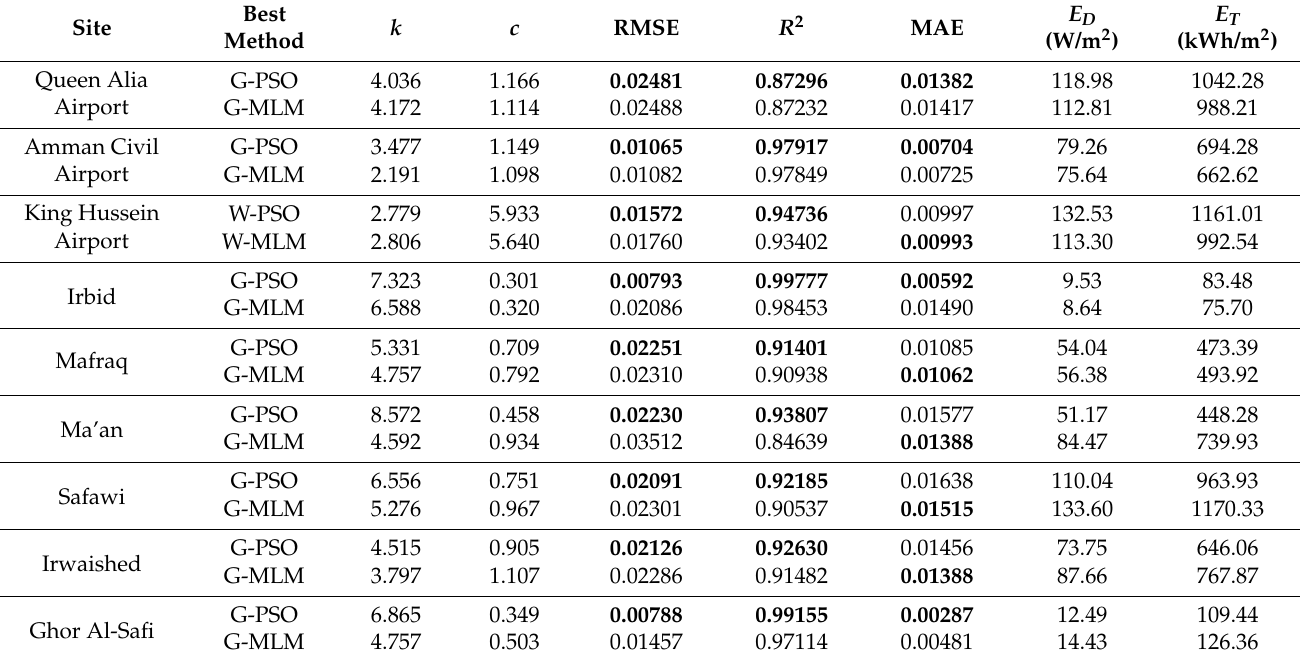
Table 5. Comparison between the best optimization method (PSO) and numerical method (MLM) according to parameters, indicators, power density and total available